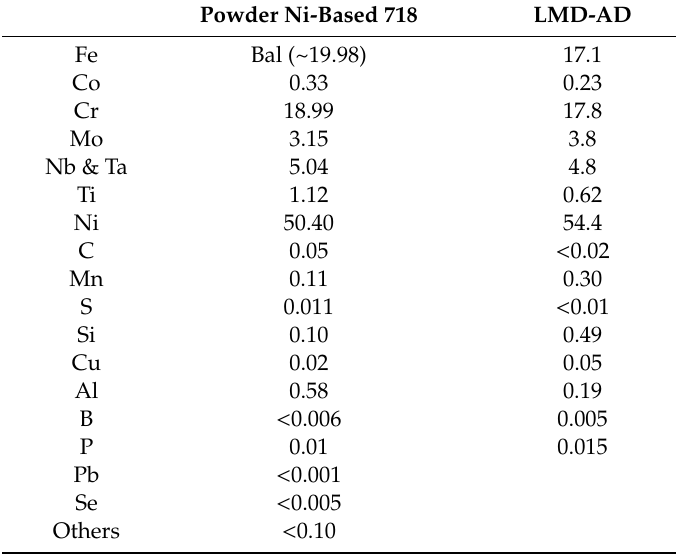
Table 3. Chemical composition of the powder material and the LMD-AD